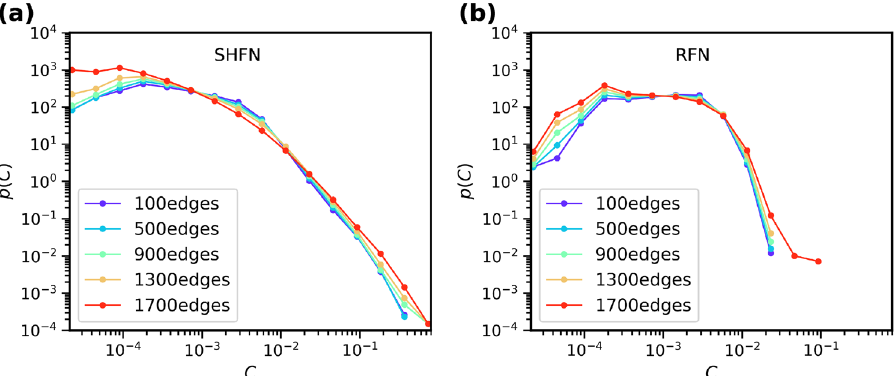
Figure 4. Evolution of GEBC statistics with accumulating damage. p ( C ) vs. C curves after 100, 500, 900, 1300 and 1700 failed edges, for hierarchical SHFN ( a ), and non-hierarchical RFN ( b ). In all simuations L = 128, k = 3